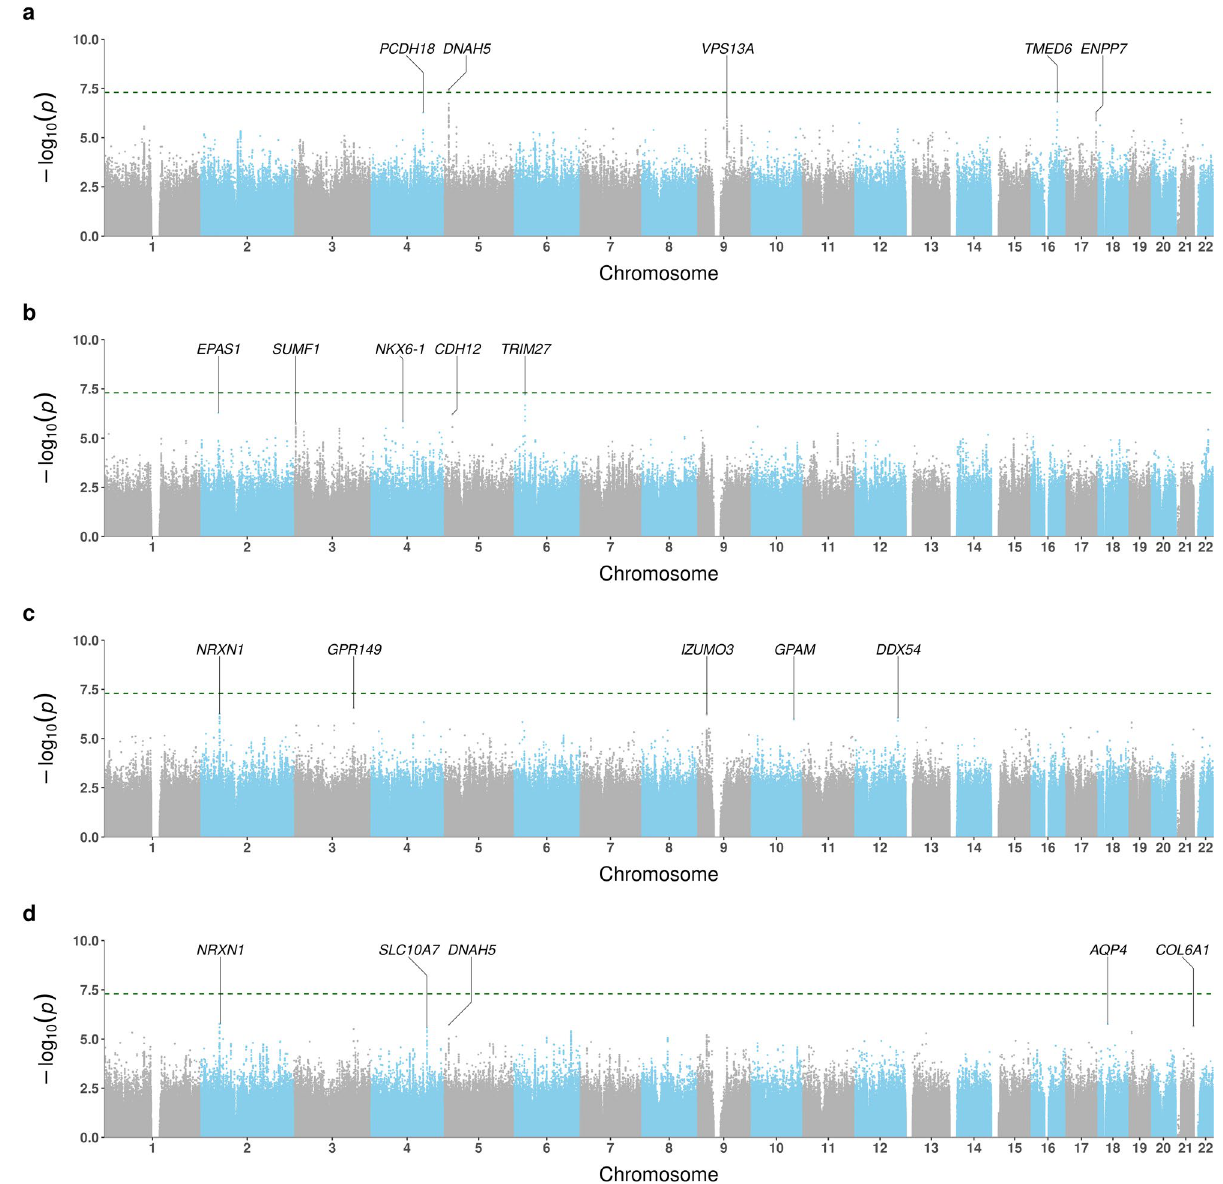
Figure 1. Manhattan plots of BDR GWAS results for ( a ) Puerto Ricans, ( b ) Mexicans, ( c ) African Americans, and ( d ) trans-ethnic meta-analysis. Top 5 loci of each result were annotated with the nearest protein-coding genes. The green horizontal dashed line indicates a genome-wide significance threshold of 5 × 10 –8